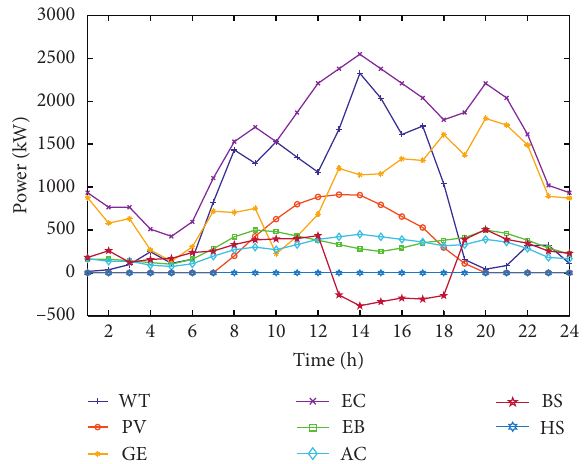
Figure 10: Real-time output value of each equipment under the priority of power load.